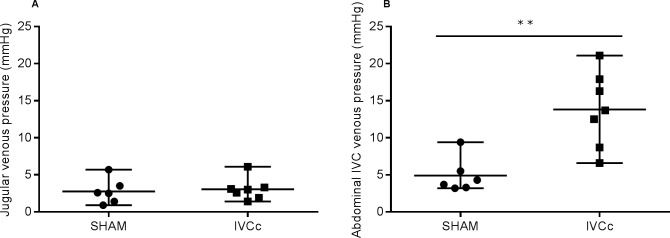
Constriction of the thoracic IVC induced an increase in abdominal central venous pressure below the constriction within 12 weeks after surgery.Venous pressure measured in (A) the jugular vein above the constriction level and (B) the abdominal IVC below the constriction level in sham-operated (SHAM, n = 6) and IVC-constricted rats (IVCc, n = 7). Based on the Shapiro-Wilk normality test, data were analyzed using an unpaired t-test (A) or a Mann-Whitney test (B). Data are shown as median, minimum and maximum. ** denotes p < 0.01. CVP = central venous pressure, IVC = inferior vena cava, IVCc = IVC-constricted rats.